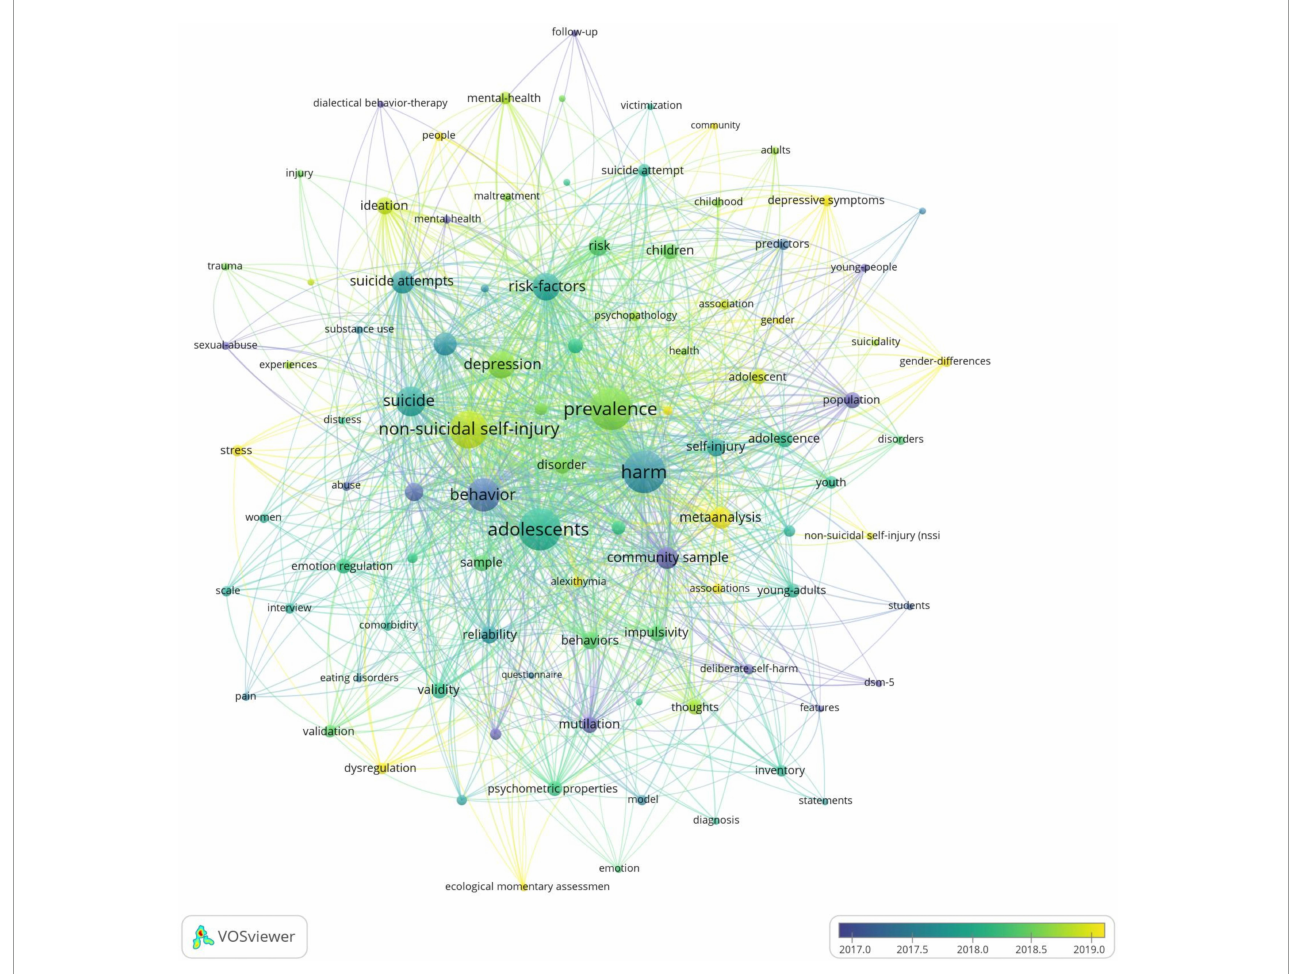
FIGURE13 The overlay visualization of keywords generated by VOSviewer. The color of the nodes and lines indicated corresponding average appearing year of